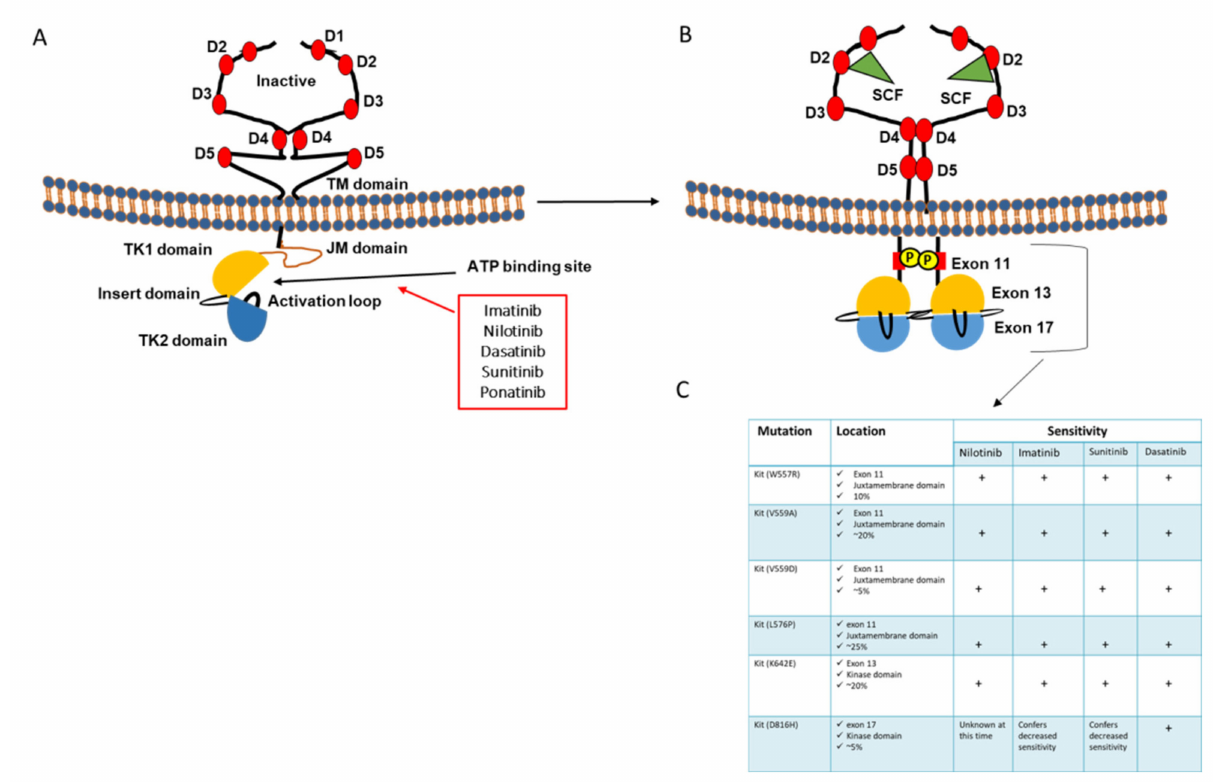
Figure 1. c-KIT structure, activation and mutations in melanoma. ( A ) The extracellular domain (ECD) of c-KIT consists of five Ig-like domains (D1–D5) followed by a transmembrane domain (TM), juxtamembrane domain (JM), tyrosine kinase 1 domain (TK1), insert domain, tyrosine kinase 2 domain (TK2), and activation loop domain. ( B ) Ligand homodimers bind to two c-KIT receptors, which interact with each other across the dimer interface. Dimerization mediates conformational changes and transphosphorylation of intracellular tyrosine residues. ( C ) Locations of most frequent c-KIT mutations in melanoma and its association with variable sensitivity to different RTK